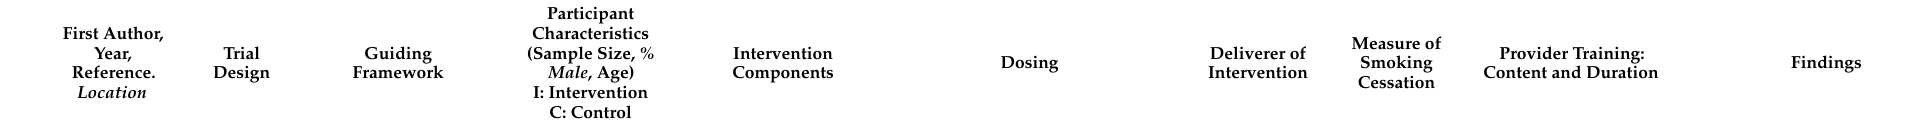
Table 1. Study and Participant Characteristics, Intervention Components, and Primary Outcome